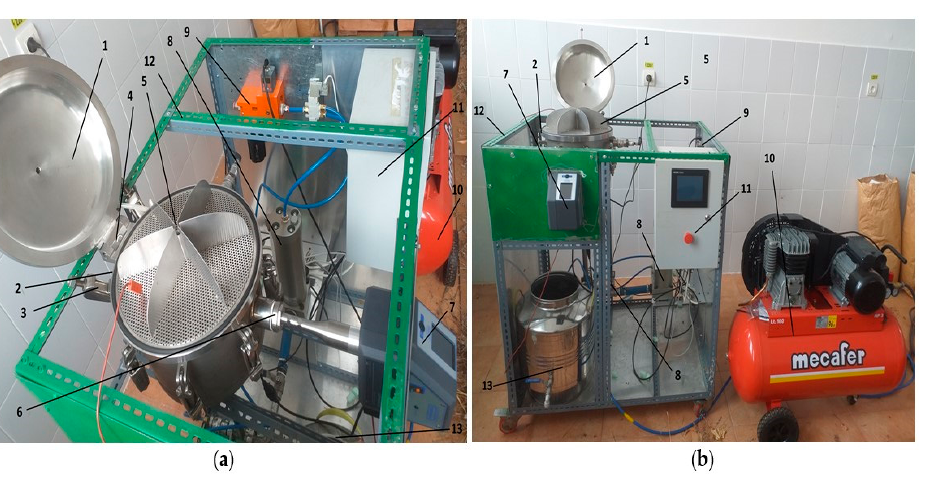
Figure 5. The fi nal design of the pilot equipment used for the extraction of bioactive substances, using a hybrid ultrasound and high-pressure technology: ( a ) Experimental Extraction Pilot top view, ( b ) Experimental Extraction Pilot side view.